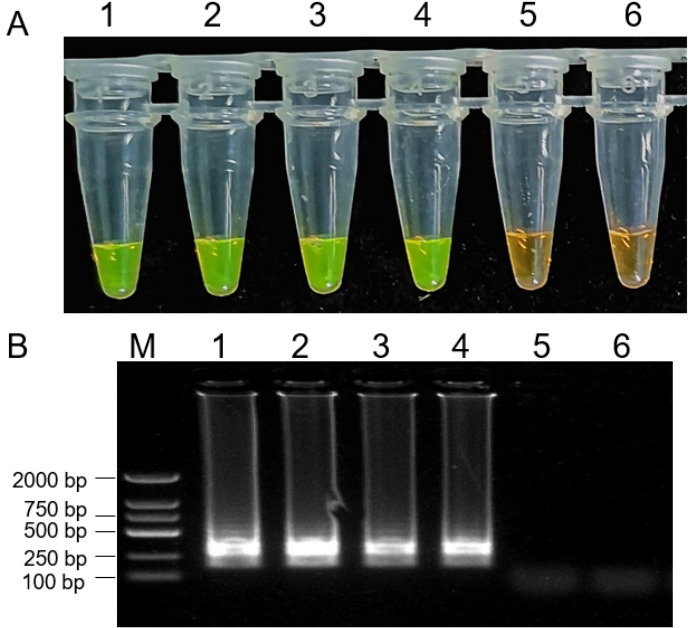
Figure 7. Detection of the Botryosphaeria dothidea in tissue samples from diseased kiwi fruits via LAMP assay. 1000 × SYBR Green I color change-based LAMP product detection ( A ). Agarose gel electrophoresis-based LAMP product detection ( B ). M: DNA marker 2 k, 1: DNA from Botryosphaeria dothidea isolate mycelium, 2: DNA from diseased kiwi fruit infected with Botryosphaeria dothidea from the pathogenicity determination experiment, 3,4: DNA from diseased kiwi fruit infected with Botryosphaeria dothidea from field, 5: DNA from healthy kiwifruit fruit, 6: water.